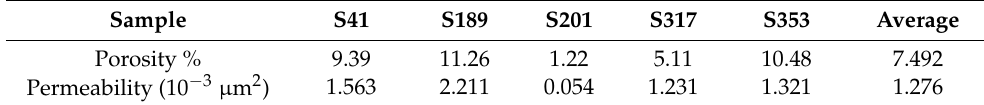
Table 3. The porosity and permeability of the sample with typical